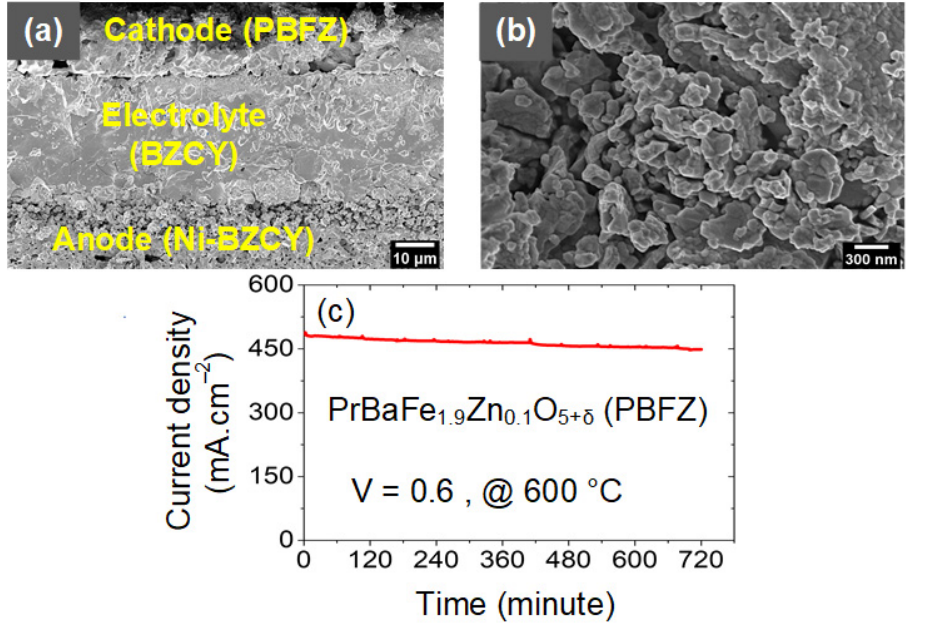
Figure 6. Short-term performance stability and microstructure: ( a ) SEM micrograph of NiO- BZCY/BZCY/PBFZ single-cell; ( b ) SEM micrographs of PBFZ cathode; ( c ) I-T curves with 0.6 V of a single cell at 600 °C.